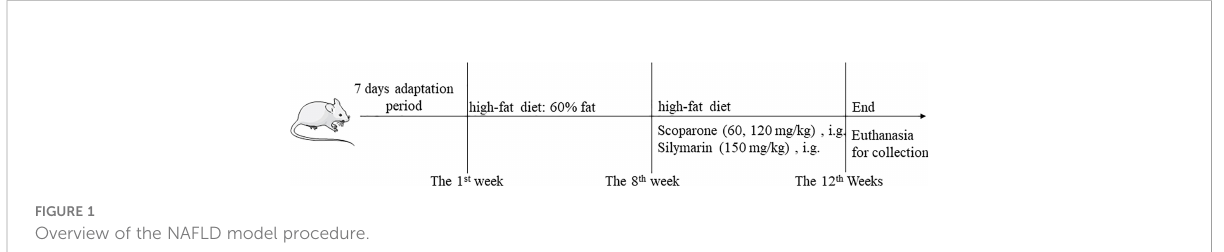
FIGURE 1 Overview of the NAFLD model